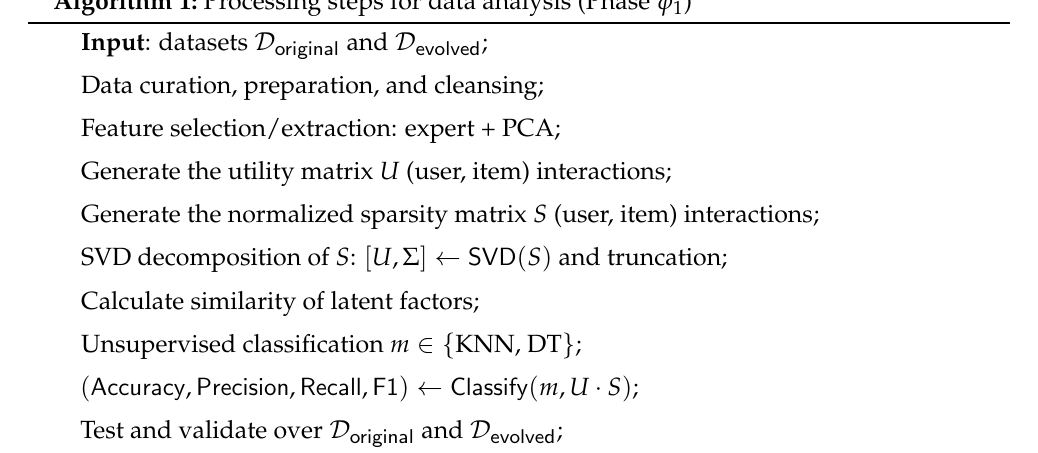
Algorithm 1: Processing steps for data analysis (Phase ϕ 1